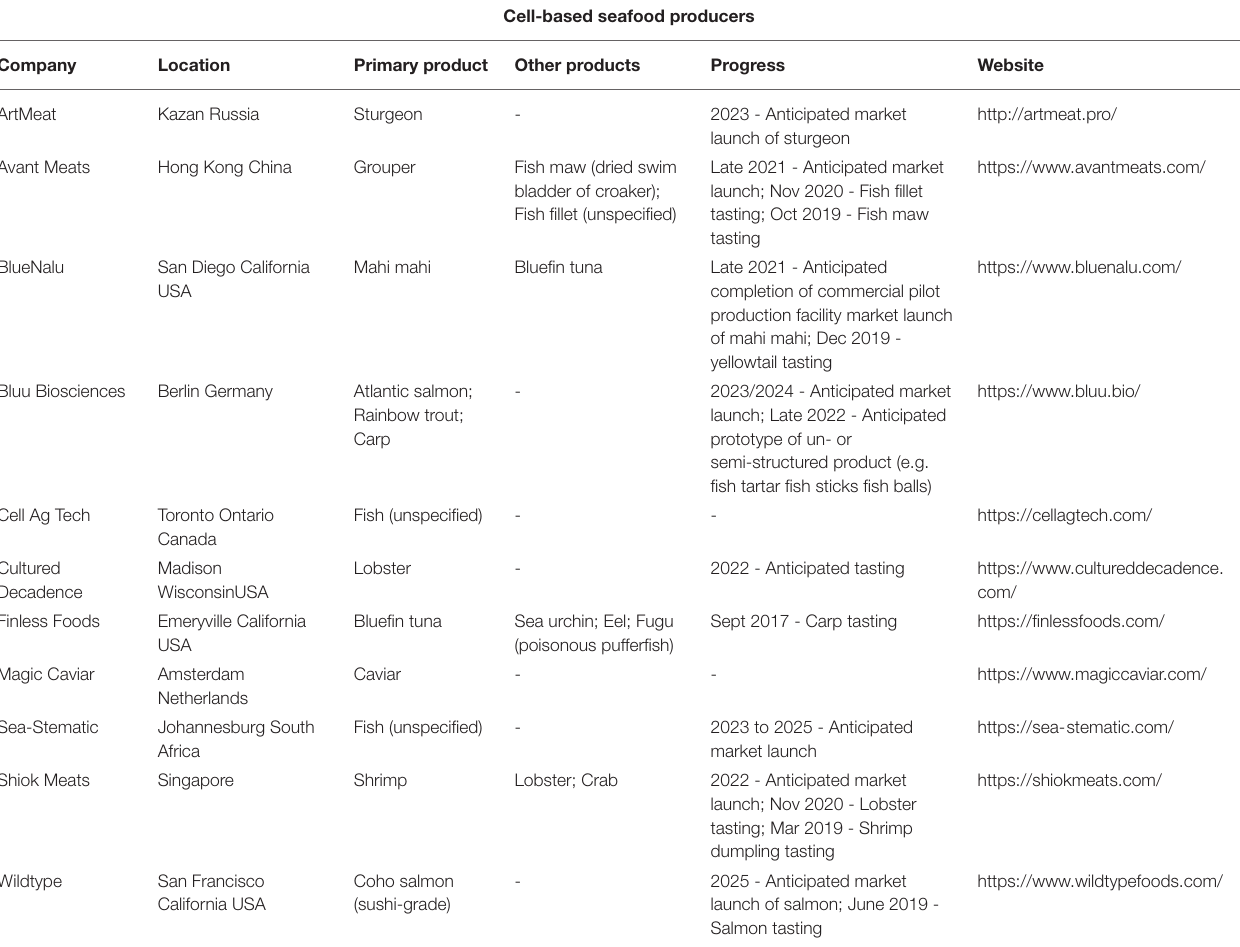
TABLE 1b | Current cell-based seafood producers, products, and progress to date (as of 29 July